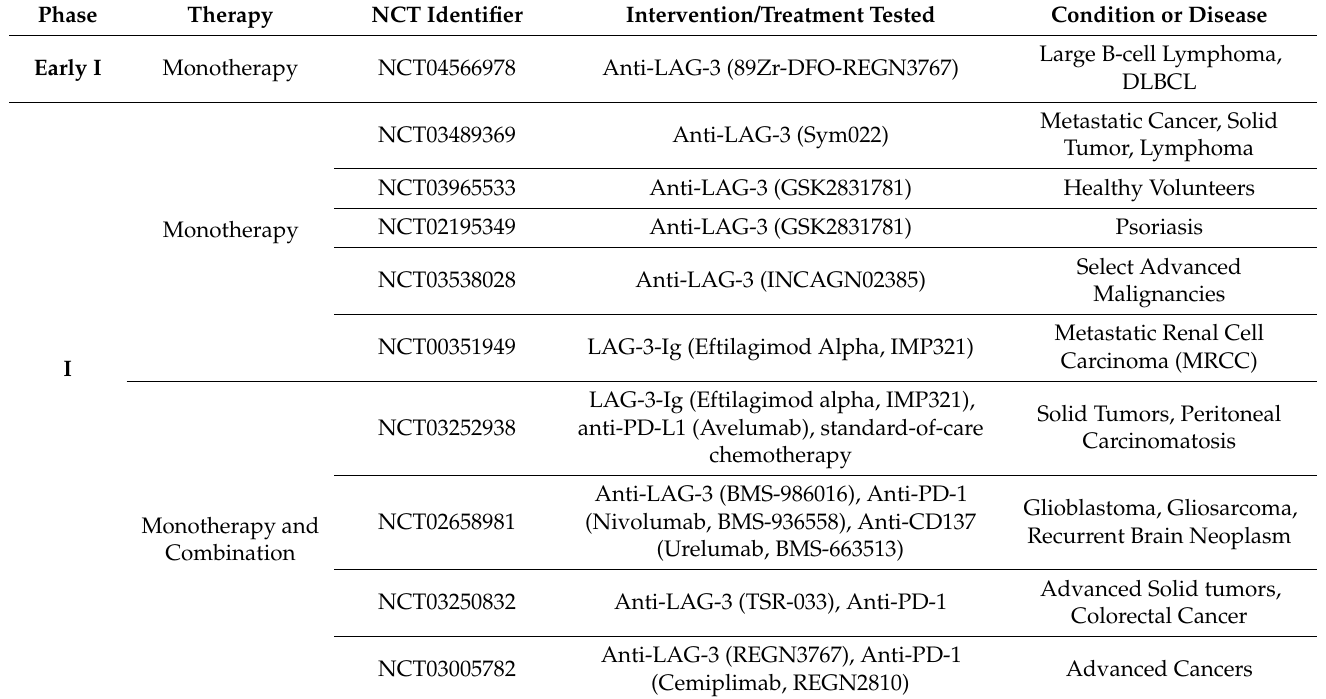
Table 2. Clinical landscape of LAG-3-targeted therapy (https://clinicaltrials.gov/, accessed on 2 May